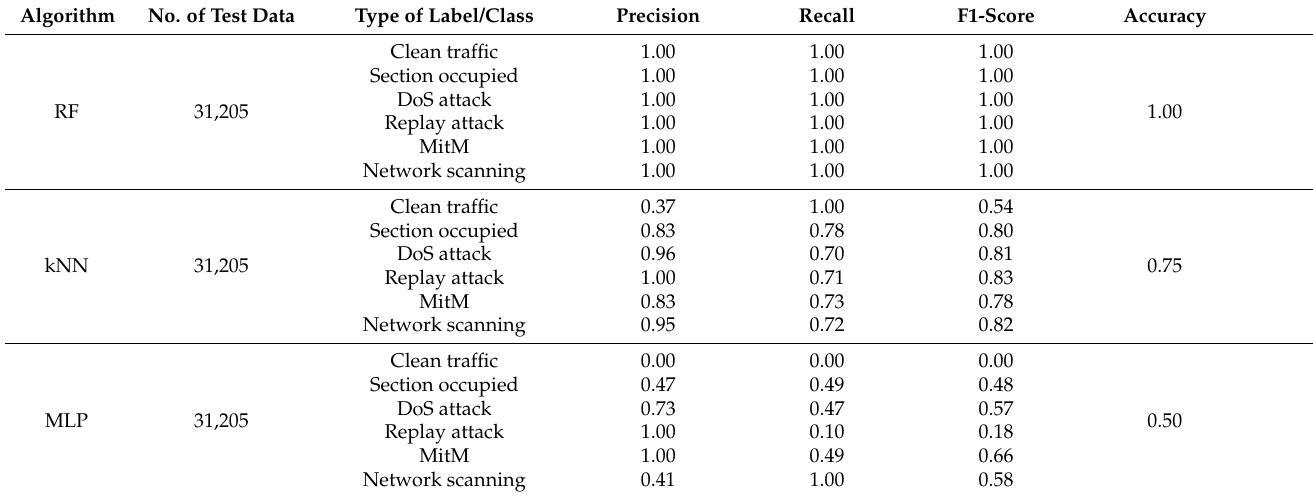
Table 4. Comparison of the most successful algorithms of classical ML.